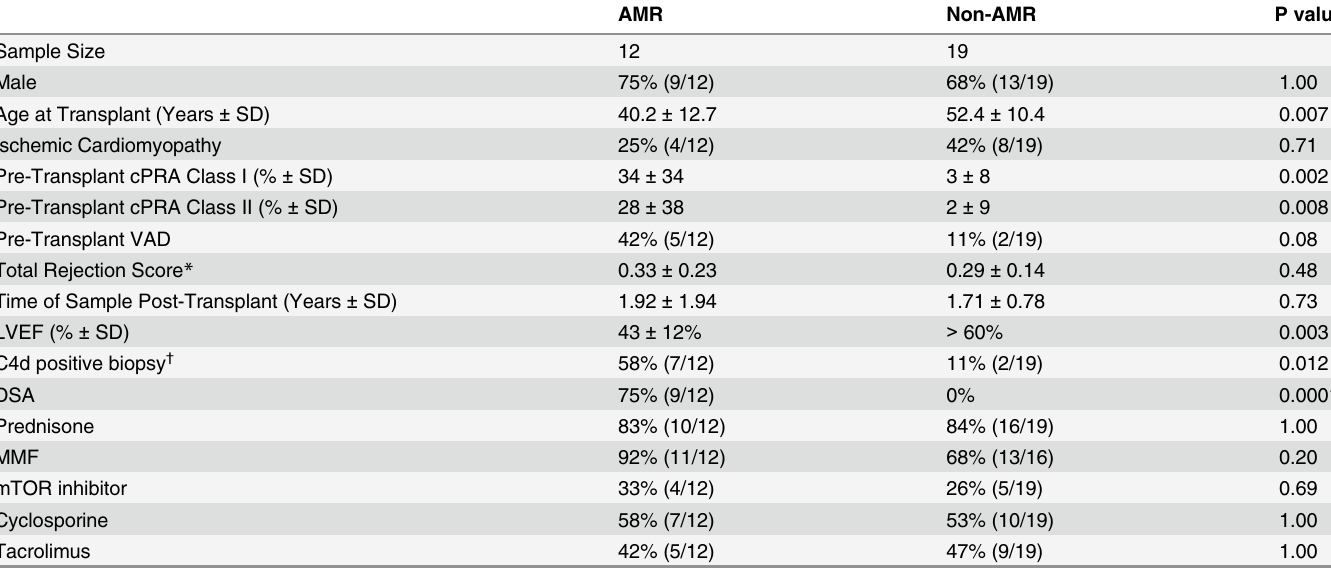
Table 4. Post-Transplant Study: Comparison of AMR and non-AMR patient